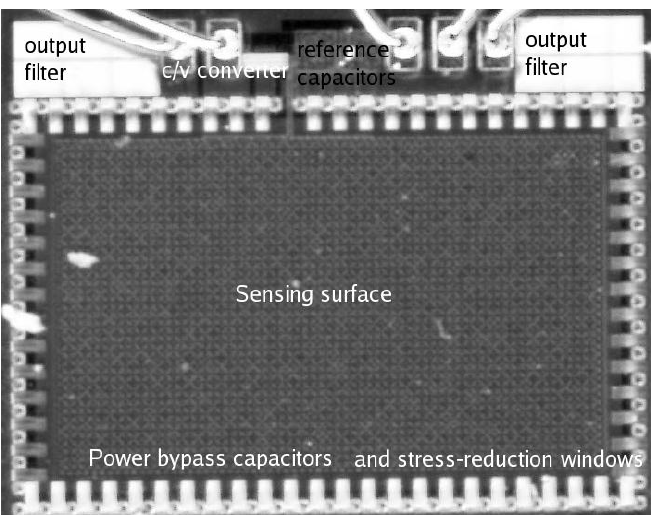
Figure 2. Microphotograph of the humidity